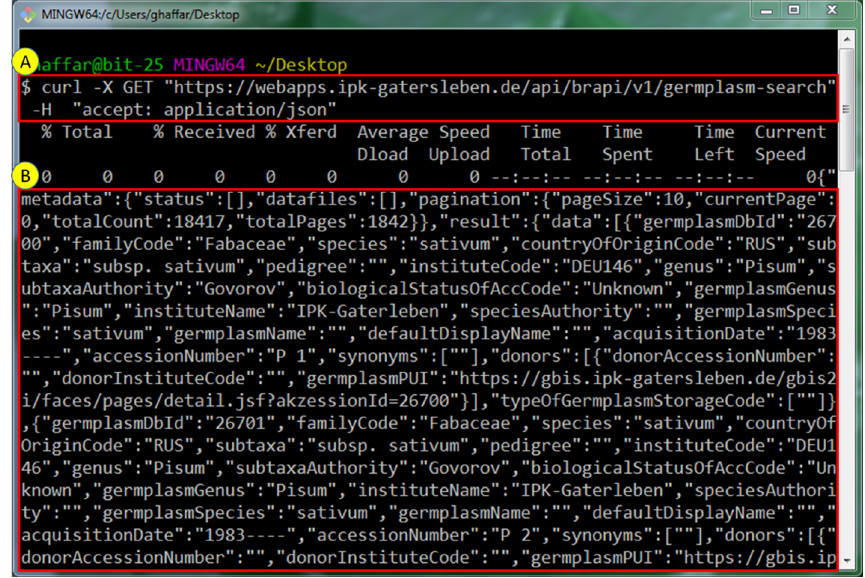
Figure 8: Accessing Germplasm resource REST endpoint using Linux cURL command line tool.